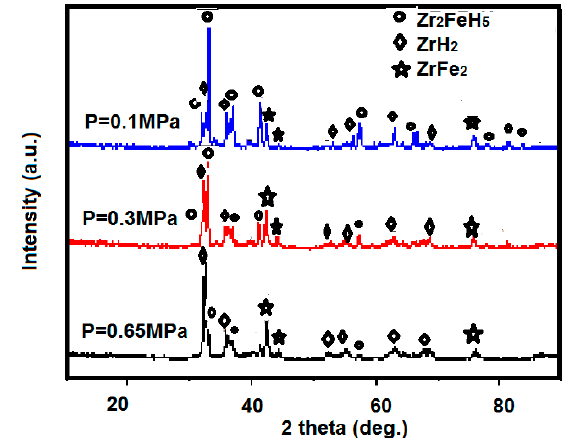
Figure 6. XRD pattern of Zr 2 Fe alloy after hydrogen absorption at different initial hydrogen pressures after activation at 400 °C for 3 h.